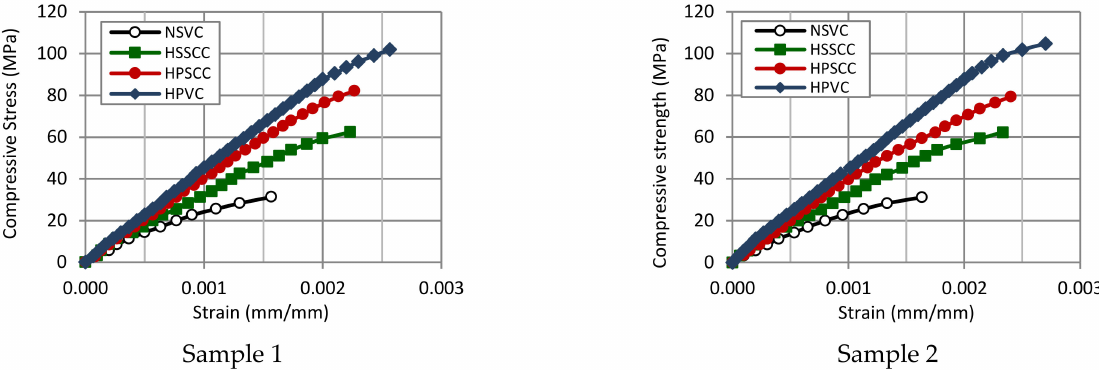
Figure 5. Stress-strain relationships for the four concrete